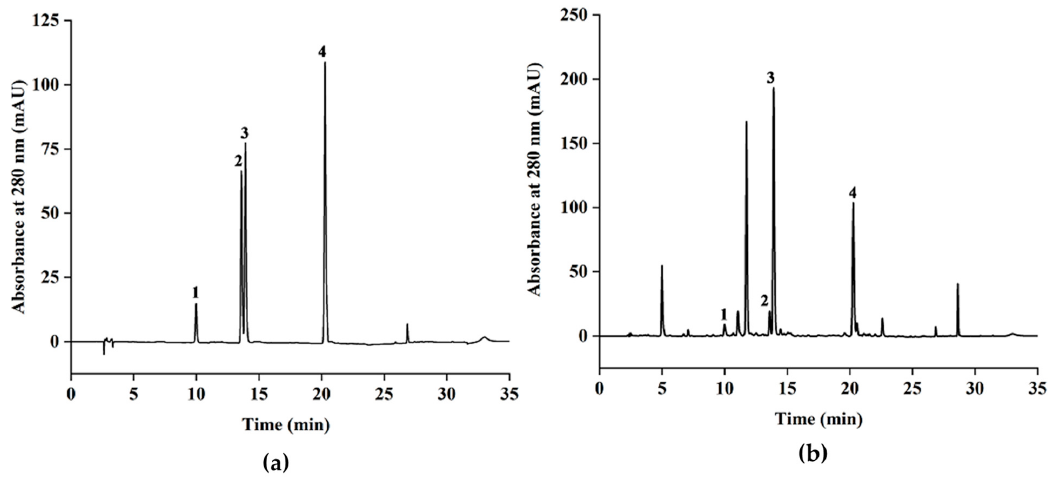
Figure 4. HPLC analysis of the mixture of four commercial standards of catechins ( a ) and green tea extract obtained by UAE-DES ( b ). Peaks 1 to 4 in ( a ) correspond to the commercial standard of ( − )-EGC (9.9 min), ( − )-EC (13.5 min), ( − )-EGCG (13.8 min) and ( − )-ECG (20.3 min), Table 6. Concentrations of four main catechins in the green tea extracts obtained by different extraction methods.